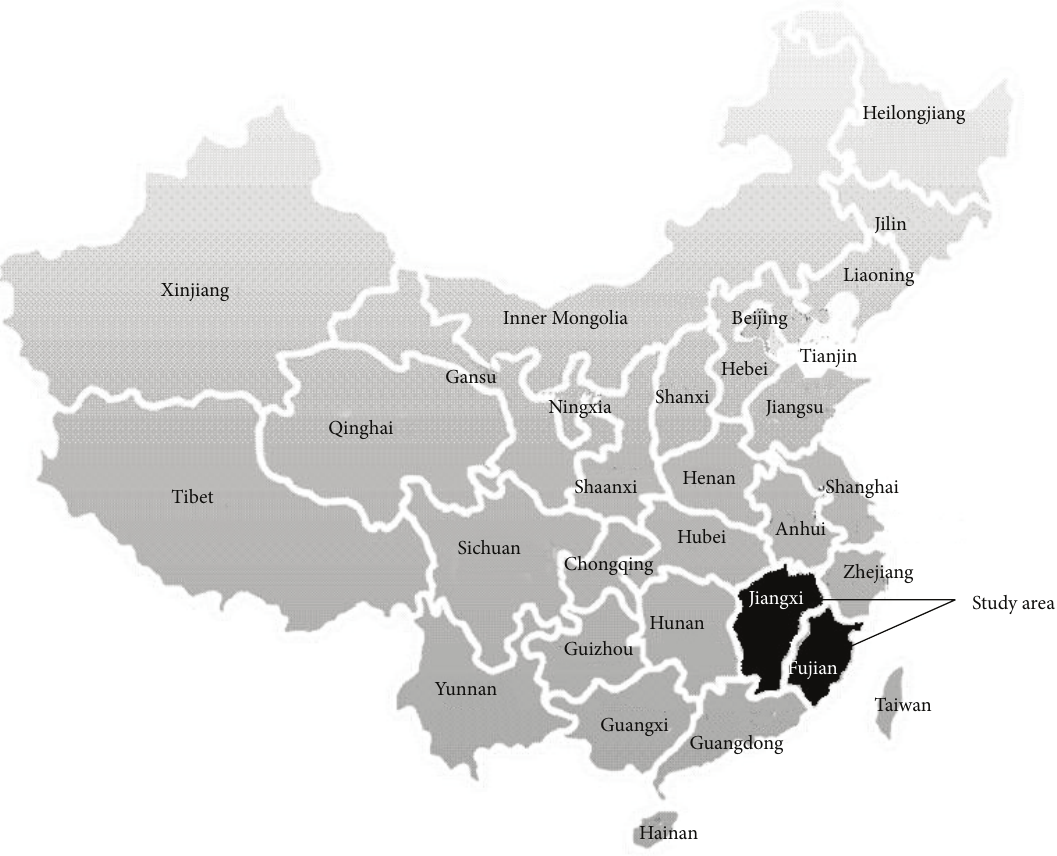
Figure 1: Map of study of area location, Fujian and Jiangxi